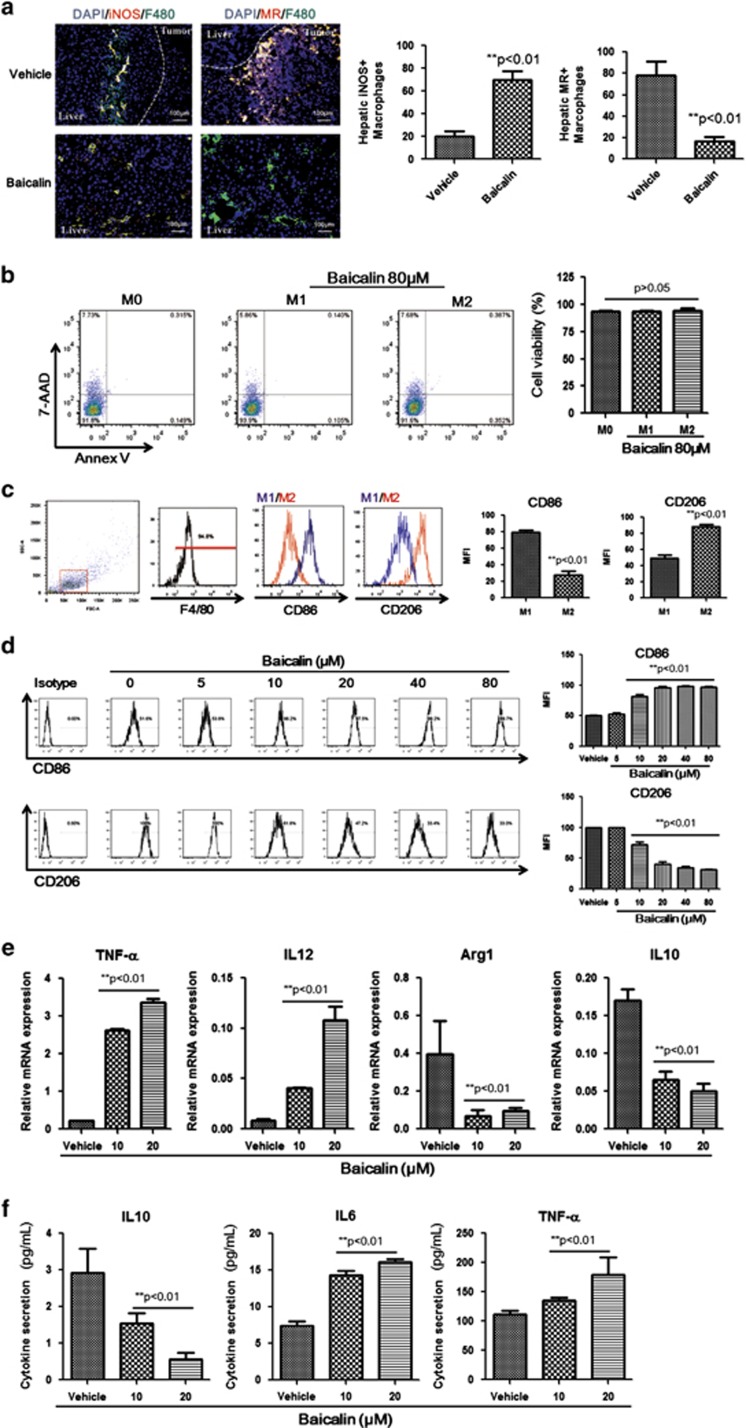
Treatment of baicalin results in reprogramming of M2-like TAMs to M1-like phenotype. (a) Baicalin treatment resulted in increase of hepatic M1-like TAMs with reduced M2-like populations. Antibodies against iNOS (M1-like marker) and mannose receptor (MR, M2-like marker) were used to stain frozen-sectioned liver tissue. Increase of iNOS-positive cells all over the liver of baicalin-treated mice was observed (P<0.01); while hepatic MR-positive cells within non-tumour and peri-tumour area was remarkably reduced upon baicalin treatment (P<0.01) (scale bar, 100 μm); (b) baicalin did not cause cell death in any specific type of macrophages. BMDM was cultured and differentiated as described in Materials and Methods. A relatively high dose of baicalin (80 μM) was given to either M1-like or M2-like TAM for 48 h. Cell viability was determined with flow cytometry using Annexin V/7-AAD staining. (c) Differentiated BMDM exhibited differential patterns in CD86/CD206 expression. Antibodies against CD86 and CD206 were used to stain cell surface marker of differentiated BMDMs. F4/80 was co-stained to identify differentiated macrophage population. M1-like macrophage had higher expression of CD86 with lower expression of CD206 (P<0.01), while CD206 was induced and CD86 was relatively low in M2-like macrophage (P<0.01). (d) Baicalin treatment resulted in skewing of TAM to M1-like macrophage. TAMs were induced by culturing BMDM with tumour supernatant (TSN) as described in Materials and Methods. Cells were subjected to different doses of baicalin for 48 h. It was observed that baicalin induced skewing of TAMs into M1-like phenotype and away from M2-like in dose-dependent manner. (e) Cytokine profile in baicalin-treated TAMs favouring M1-like phenotype. RNA from baicalin-treated cells was collected and expression of TNF-α, IL12 (M1-like macrophage markers) and IL10, Arginase1 (Arg1, M2-like macrophage markers) was determined by quantitative real-time PCR. Increase of M1 markers but decrease of M2 markers was observed in baicalin-treated TAM (P<0.01). (f) Baicalin treatment induced elevated secretion of pro-inflammatory cytokine in TAMs. Cytokine concentration in cultured TAM supernatant was determined with CBA kit. TNF-α and IL6 (pro-inflammatory cytokines) levels were increased (P<0.01), while IL10 (anti-inflammatory cytokine) was reduced after baicalin intervention (P<0.01). Cytokine level was expressed as pg/ml±S.D.